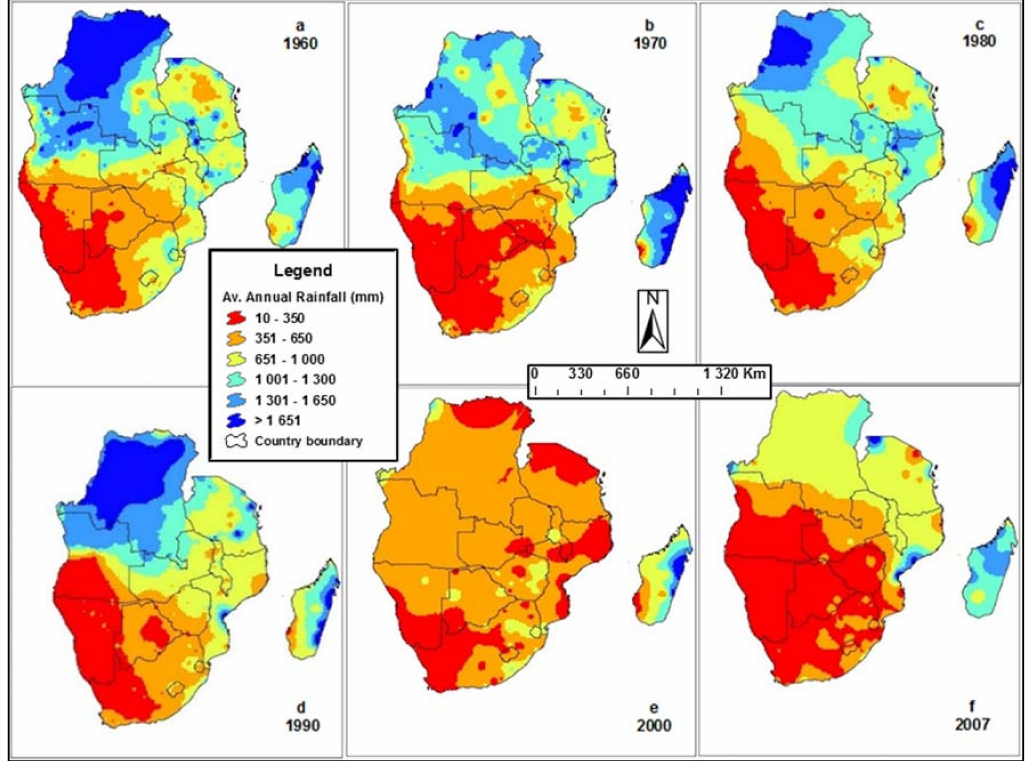
Figure 2. Spatio-temporal changes in annual rainfall distribution and variability in the SADC region in 1960, 1970, 1980, 1990, 2000 and 2007. Source: Nhamo et al.